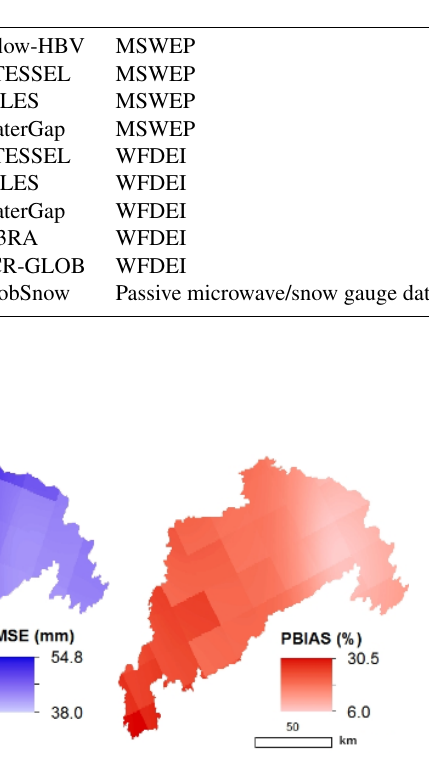
Figure 5. Error from comparison of GlobSnow SWE and interpo- lated in situ SWE